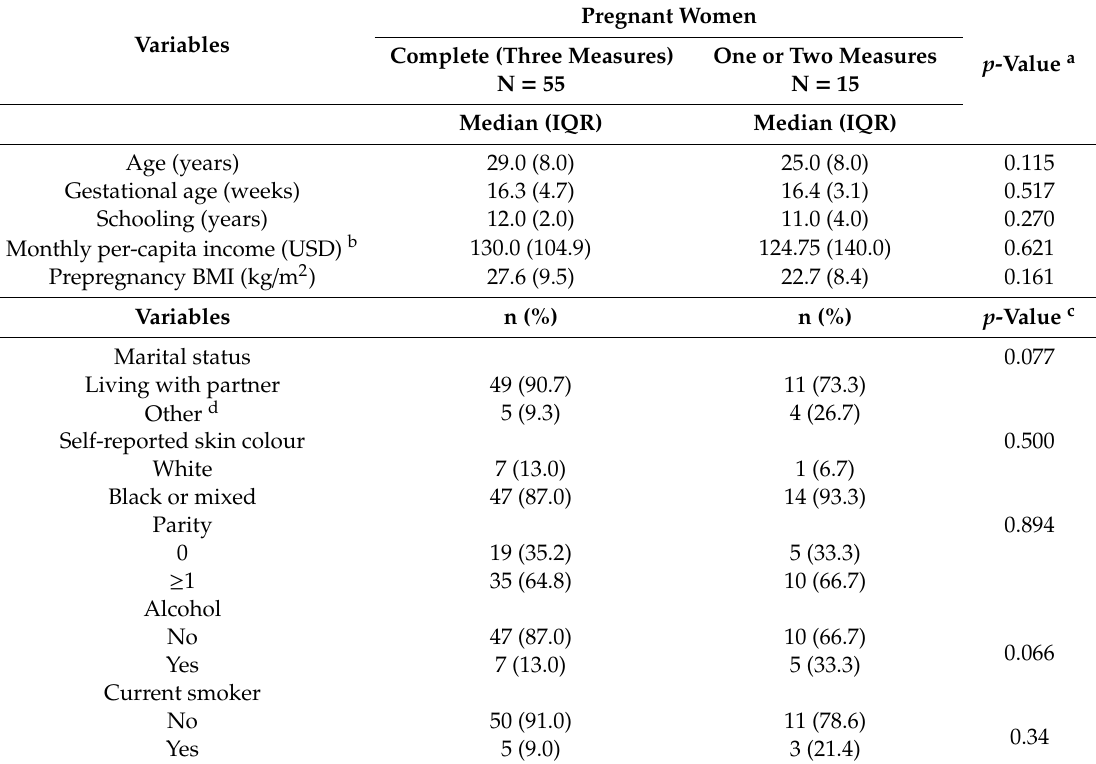
Table 3. Sociodemographic and maternal baseline characteristics comparisons of the pregnant women with periodontitis with complete data (three measures) and one or two measures from a low socioeconomic area in Rio de Janeiro,